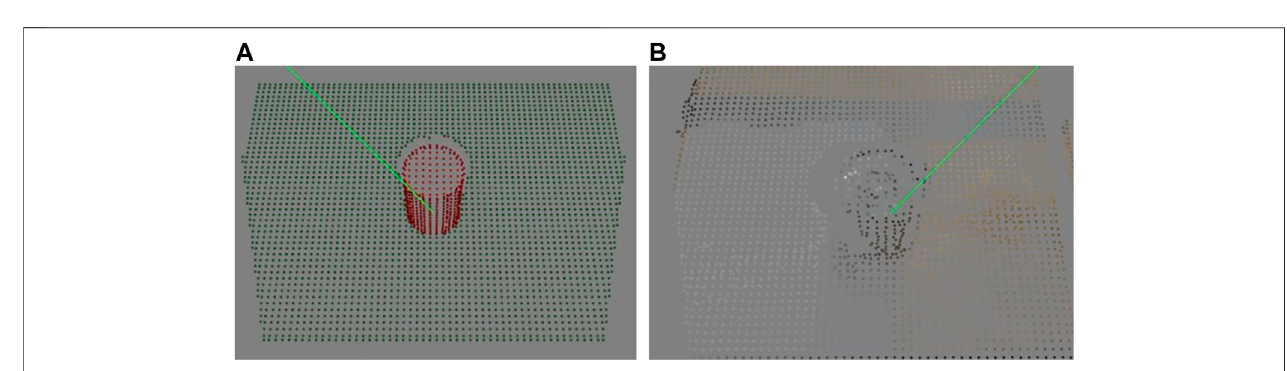
FIGURE 13 | Difference between information captured by depth sensor in simulation (A) and real world (B) for the tomato soup can (005) object. Notice the lesser surface information captured by the real world sensor.